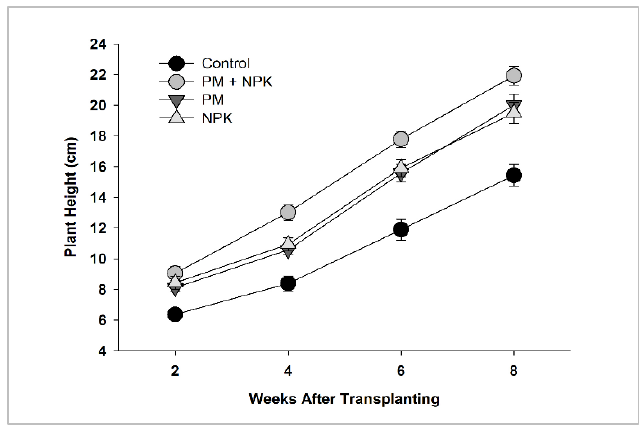
Figure 2 : Effect of inorganic and organic fertilizer on plant height (cm) of cabbage Number of